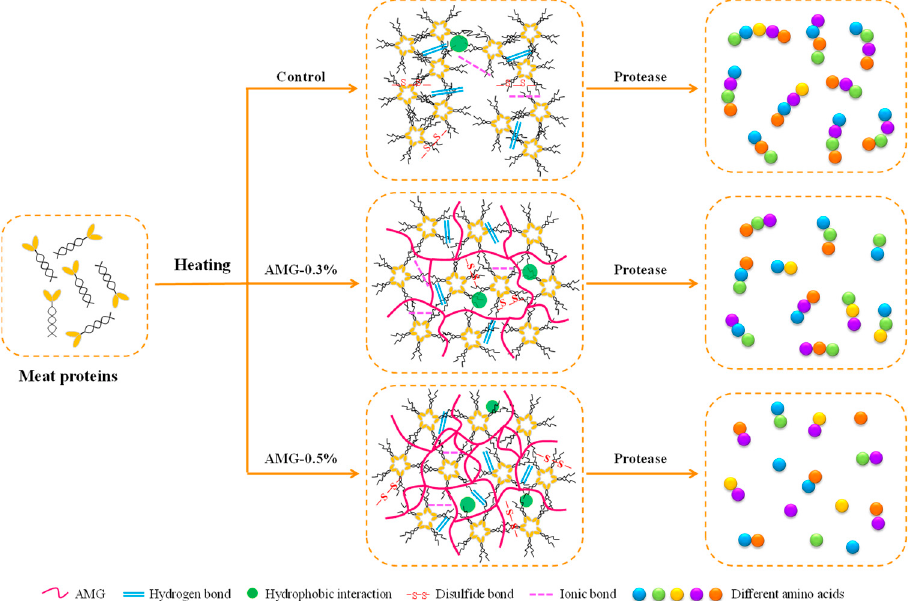
Figure 6. Mechanism diagram of the promoted quality profiles of frankfurters with or without AMG at different concentrations. Control: no added AMG; AMG-0.1%: 0.1% added AMG; at different concentrations. Control: no added AMG; AMG-0.1%: 0.1% added AMG; AMG-0.2%: AMG-0.2%: 0.2% added AMG; AMG-0.3%: 0.3% added AMG; AMG-0.4%: 0.4% added AMG; and 0.2% added AMG; AMG-0.3%: 0.3% added AMG; AMG-0.4%: 0.4% added AMG; and AMG-0.5%: AMG-0.5%: 0.5% added AMG. 0.5% added